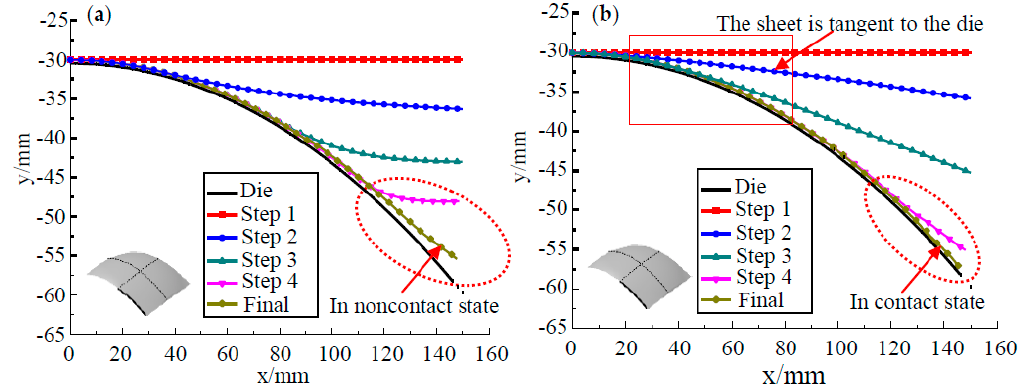
Figure 9. Longitudinal section lines of spherical part in the effective formed region. ( a ) C-SF; ( b ) UC-SF.